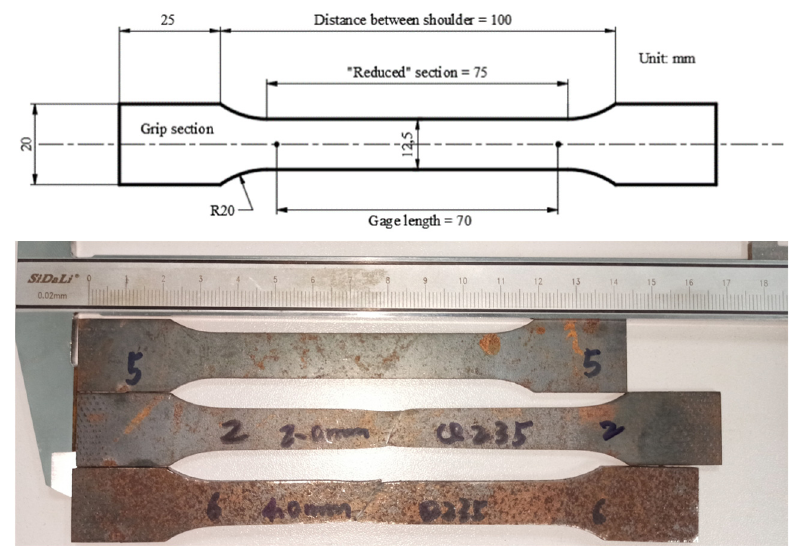
Figure 6. Dimension of the tensile test specimen. Table 2. Mechanical properties of Q235.